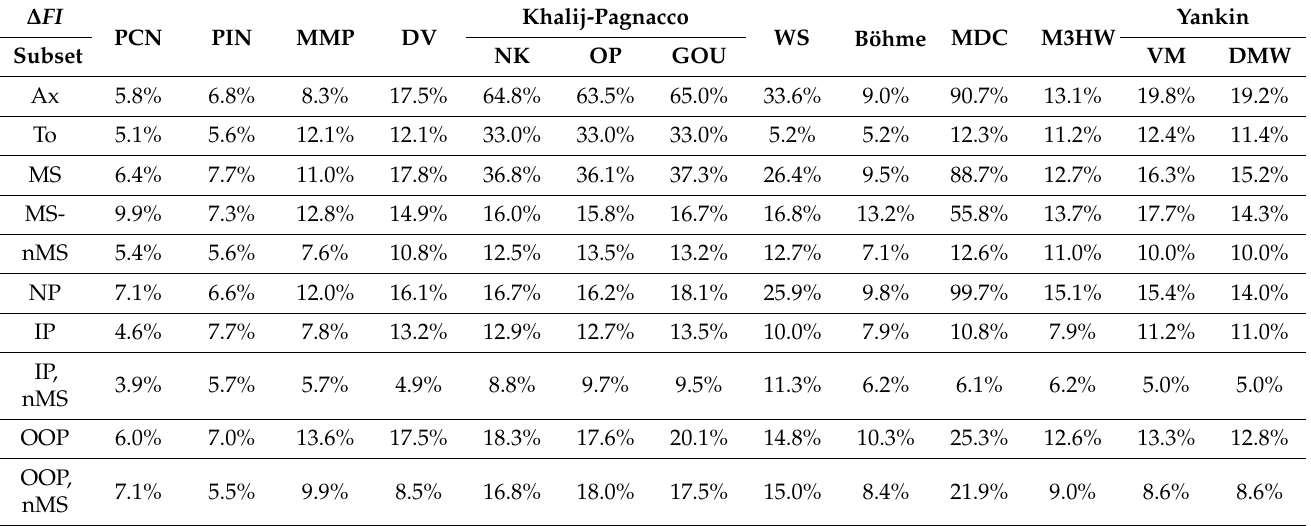
Table 12. Summary of standard deviations of the ∆ FI obtained for individual criteria and for various subgroups of